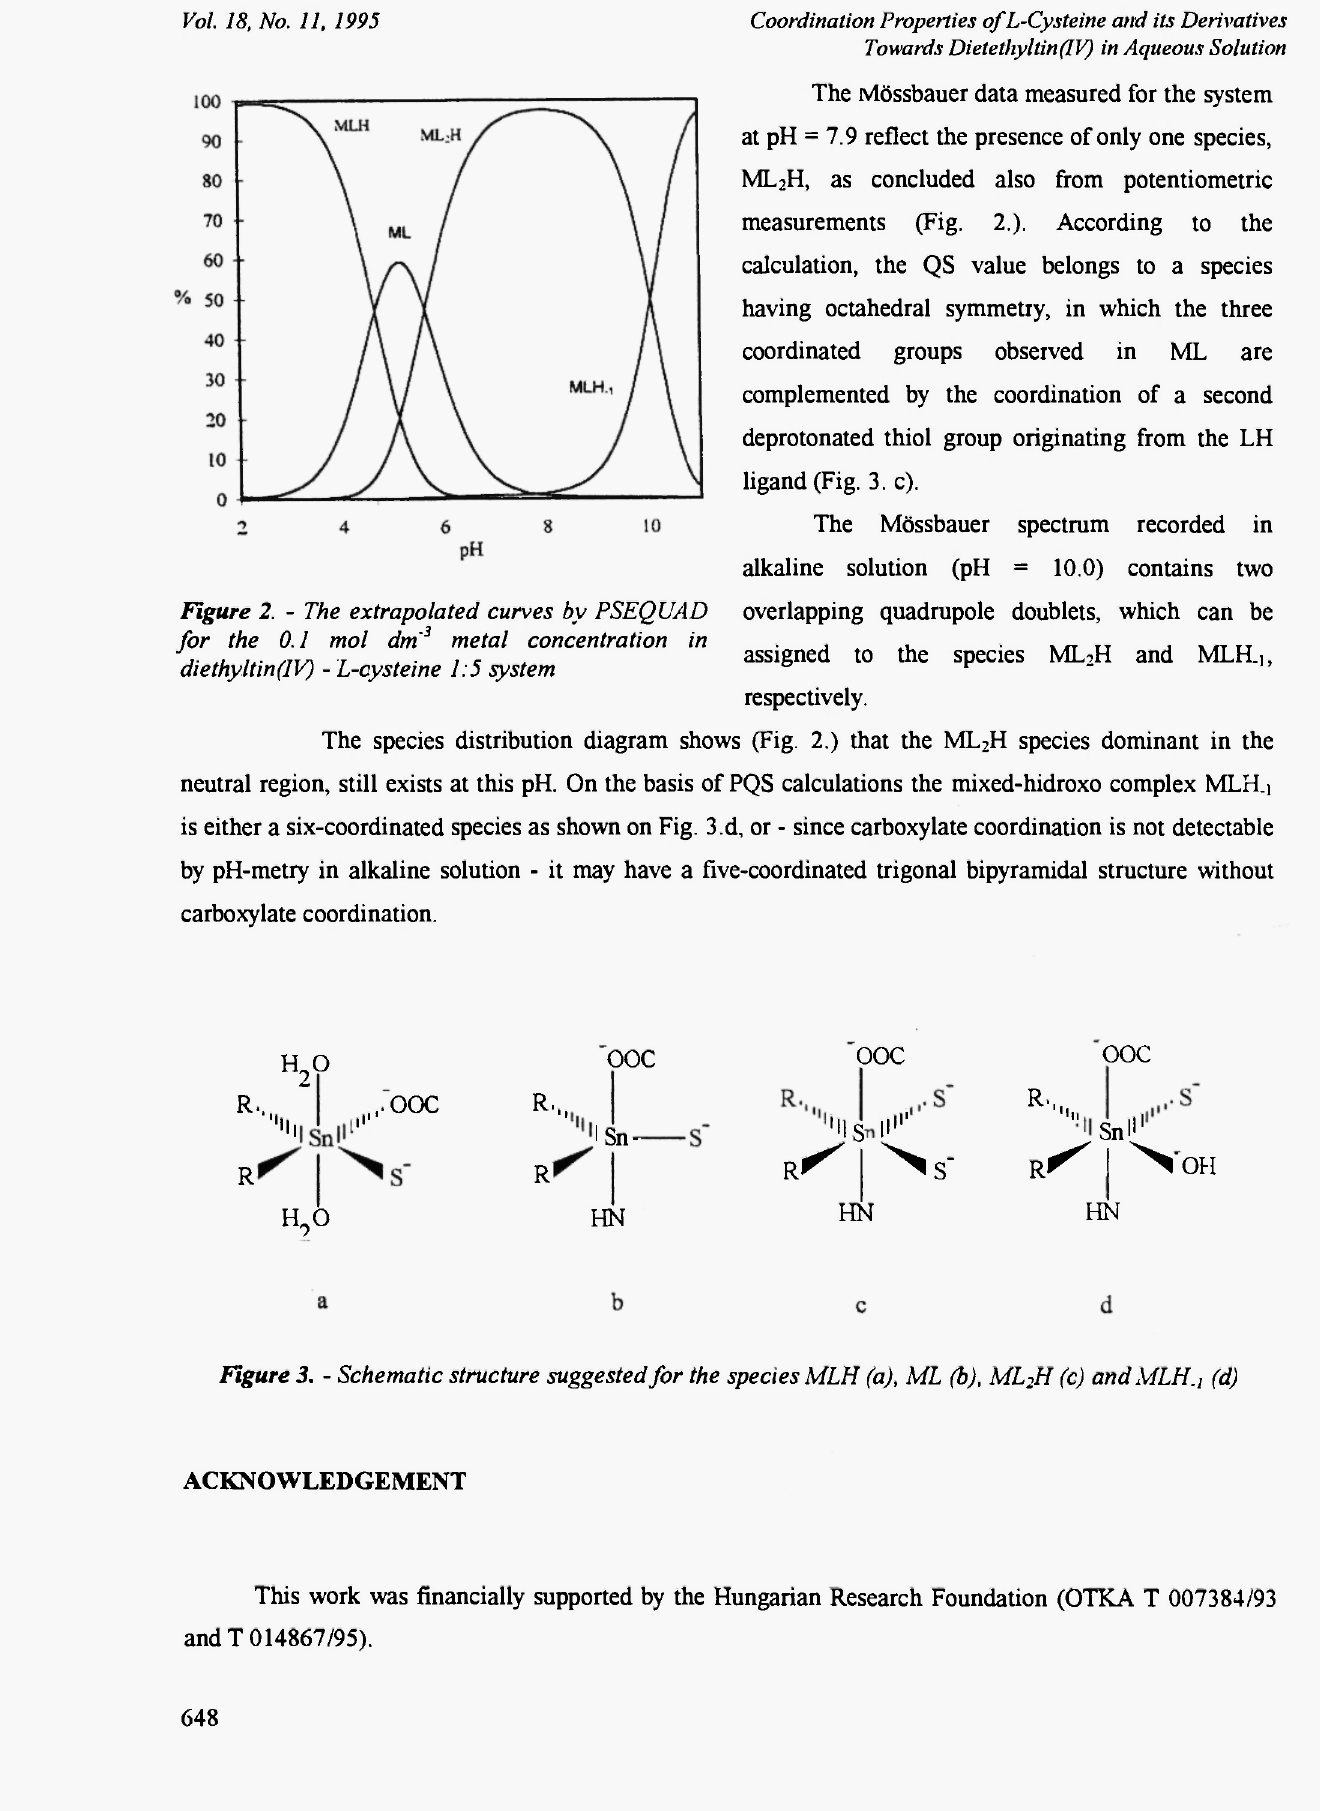
Figure 3. - Schematic structure suggested for the species MLH (a), ML (b), ML 2 H (c) and MLH.,